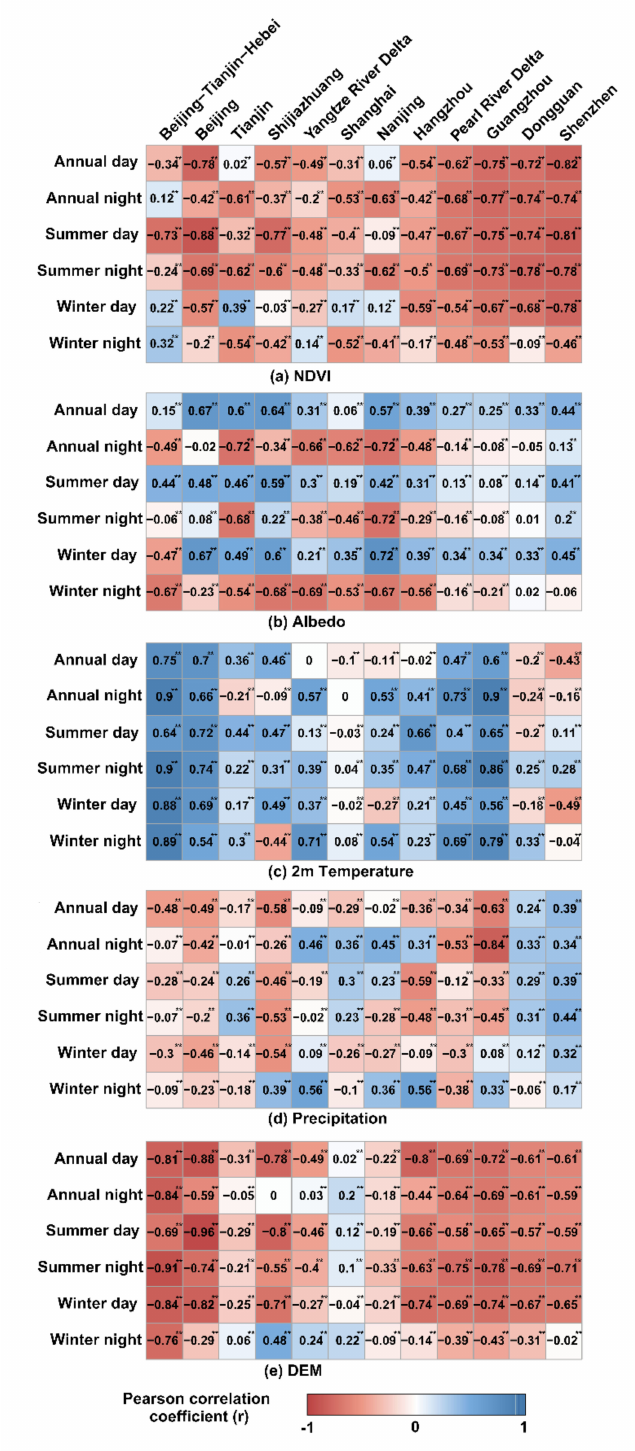
Figure 12. Pearson correlation coe ffi cients between vegetation coverage ( a ), albedo ( b ), air temperature ( c ), precipitation ( d ) and altitude ( e ) and LST during daytime and nighttime of annual, summer and winter seasons across di ff erent cities and urban agglomerations. ** denotes that the Pearson correlation coe ffi cients are significant statistically at 0.01 significance